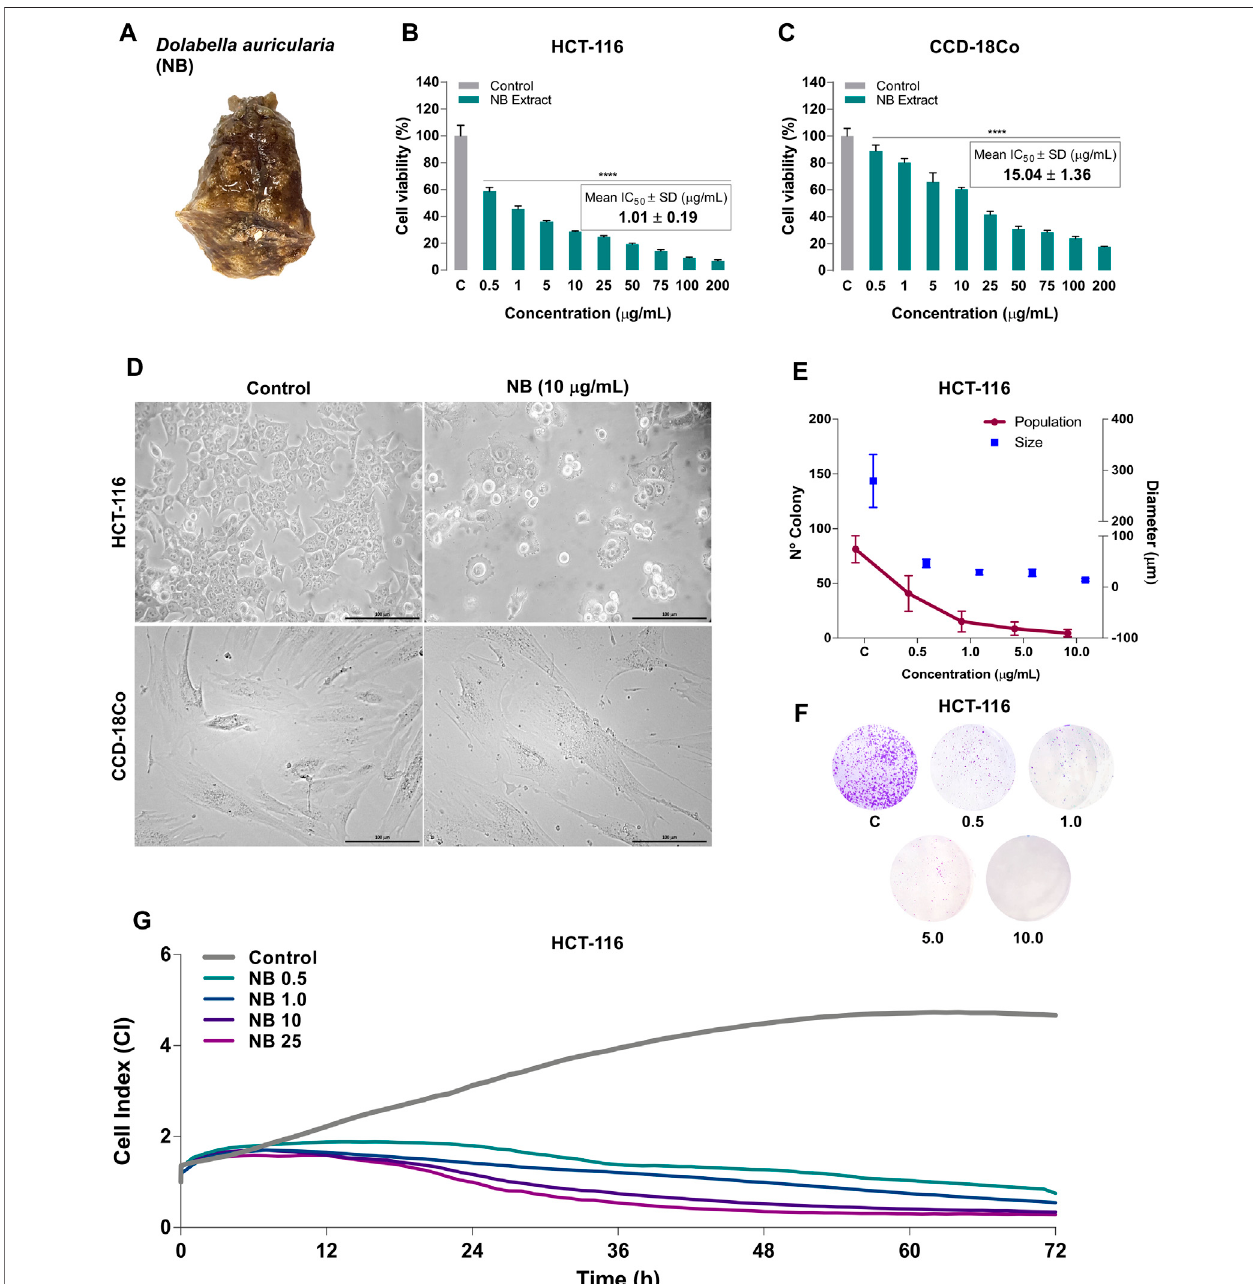
FIGURE1| Effectof Dolabellaauricularia extract(NB)ontheproliferationofcoloncancerandnormalcelllines. (A) Photographofa Dolabellaauricularia invertebrate specimen. The cytotoxicity of various concentrations of NB extract after 24 h of treatment was tested by the MTT assay in HCT-116 (B) and CCD-18Co (C) cells. The control (C) is cells plus DMSO (extract vehicle; at less than 0.2% (v:v)). The results are reported as the mean ± SD of three independent experiments. (D) Morphology of HCT-116 and CCD-18Co untreated cells (left, control) and cells treated with NB extract (right, 10 µg/ml). (E) The survival of HCT-116 cells was measured by the clonogenicassay.Theplotshowsthesizeandnumberofcolonies.Dataarepresentedasthemean ± SDofthreeindependentexperiments. p -valueswerecalculatedby comparison with the untreated cell line using ANOVA. * p -value < 0.05, ** p -value < 0.01, *** p -value < 0.001, and **** p -value < 0.0001. (F) Colonies stained with crystal violet. (G) HCT-116cellproliferationasthecellindex(CIP)ofHCT-116wasmeasuredbyareal-timecellanalyzerusingE-platesfor72 h.Themeankineticcurvesofthree independent experiments are shown.